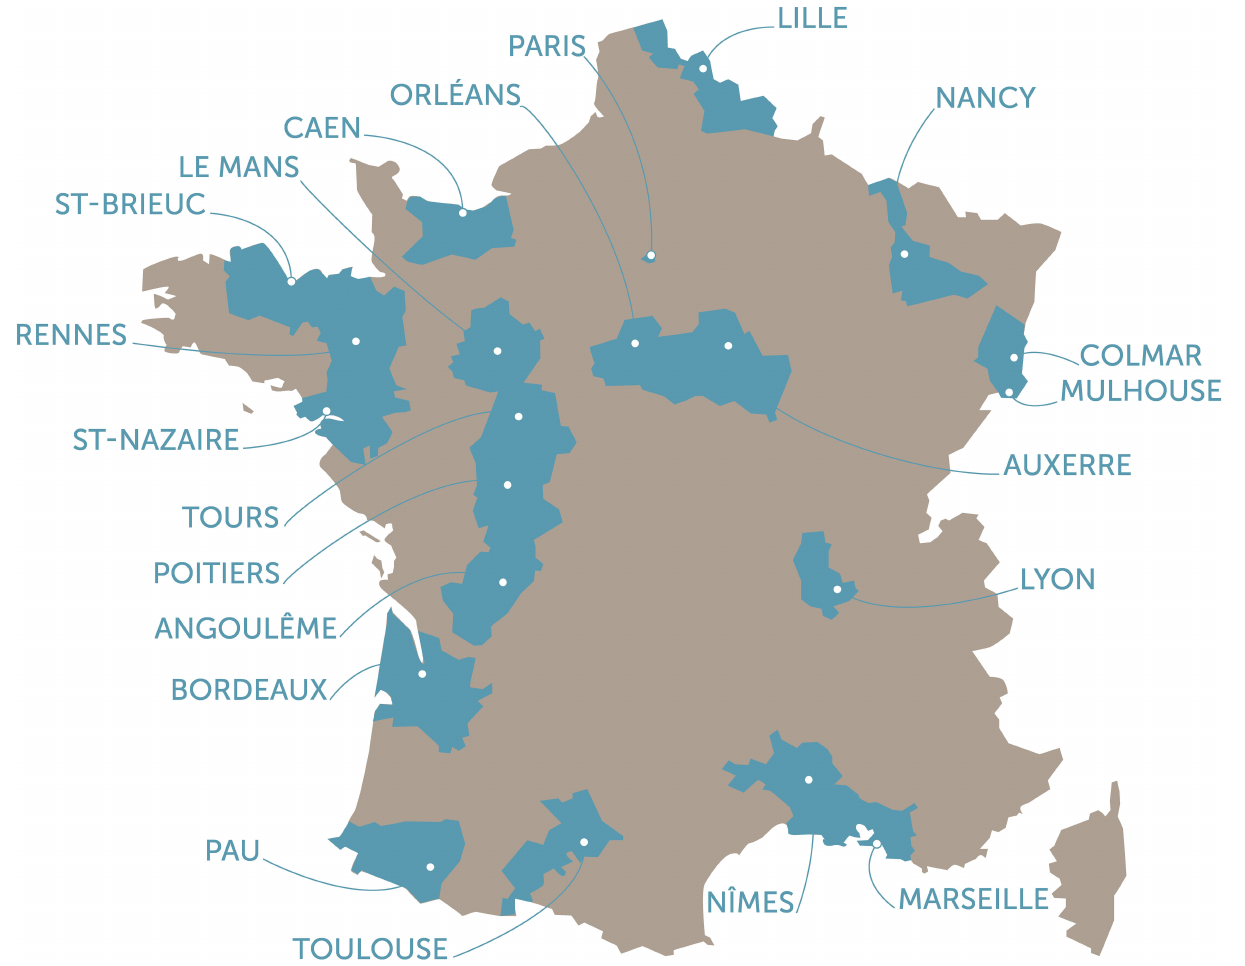
processing, before the required data are sent to the researcher in charge of the